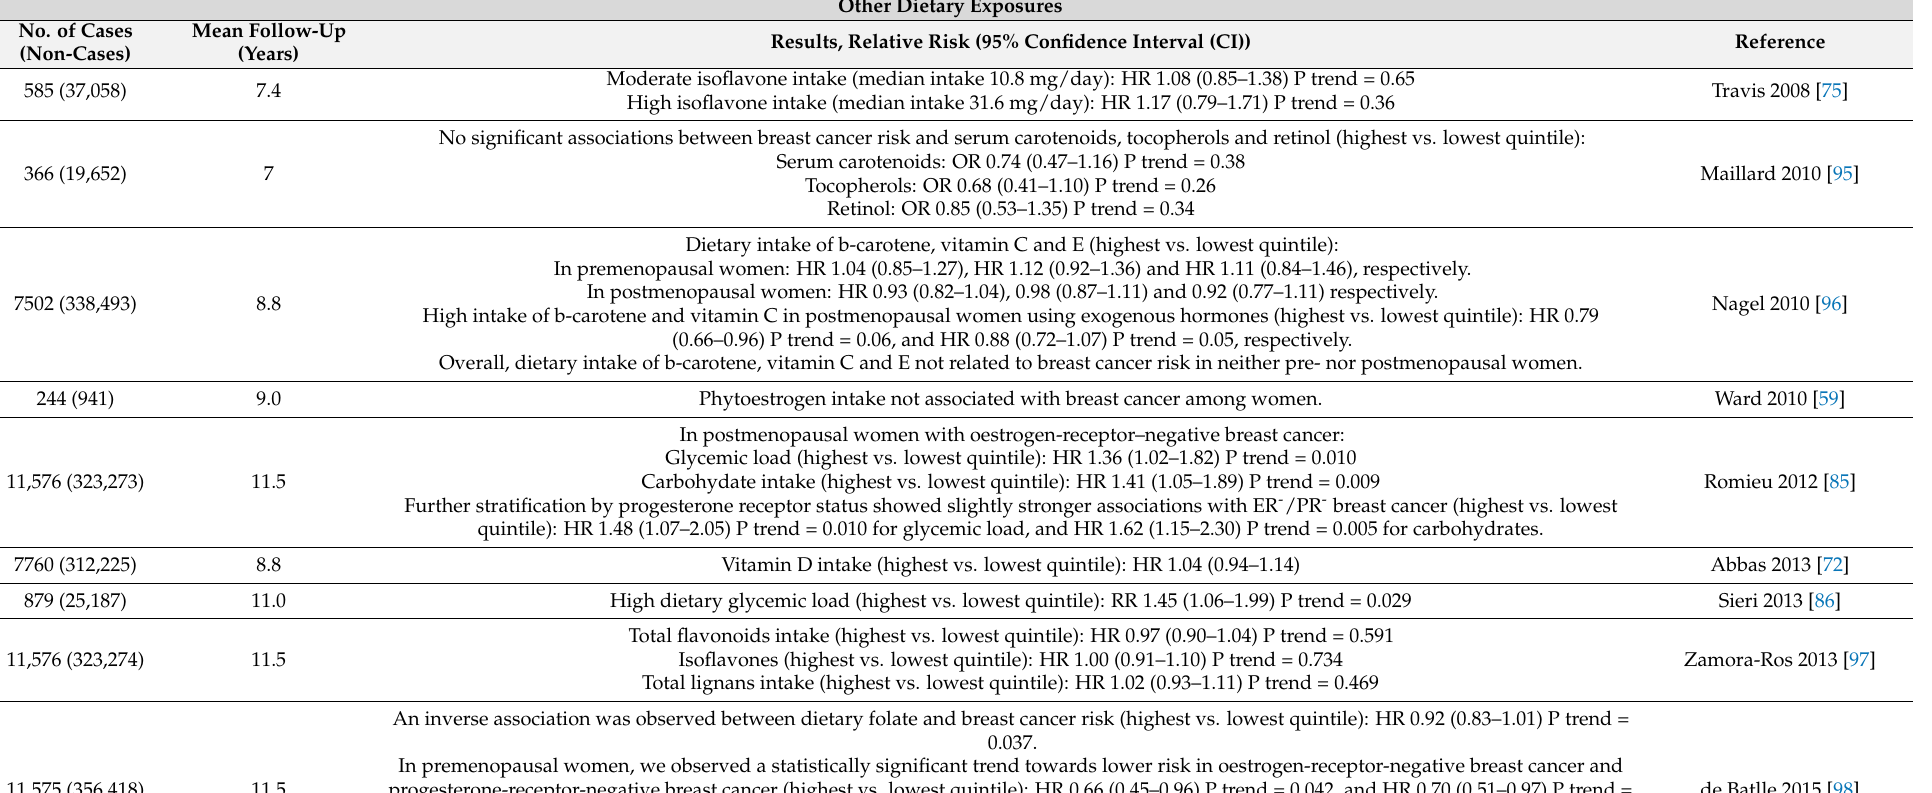
Table 2. Cont. Other Dietary Exposures